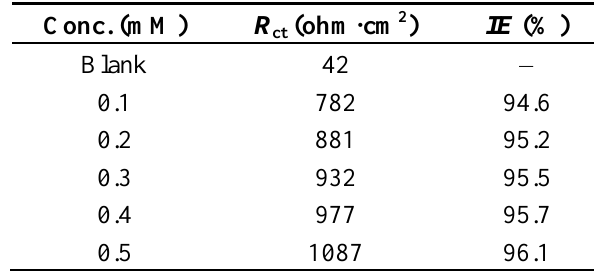
Table 3. Inhibition efficiency of PMBH calculated from electrochemical impedance spectroscopy (EIS) results with various concentrations at 30